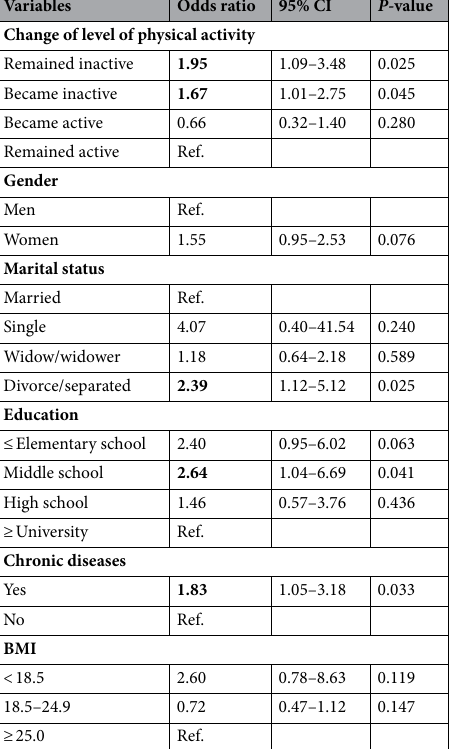
Table 3. Effect of changes in the PA groups from 2009 to 2017 and general characteristics in 2009 on lower 10% of HRQoL in 2017. PA physical activity, 95% CI 95% confidence interval, BMI body mass index. Boldface P-values indicate significance level <